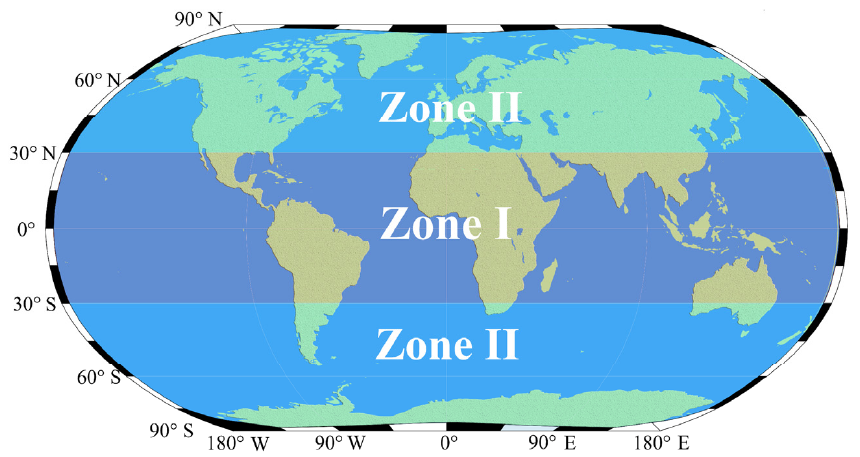
Figure 11. Division of the Earth surface into two zones from the perspective of angular sampling and sensitivity to the time sampling interval.